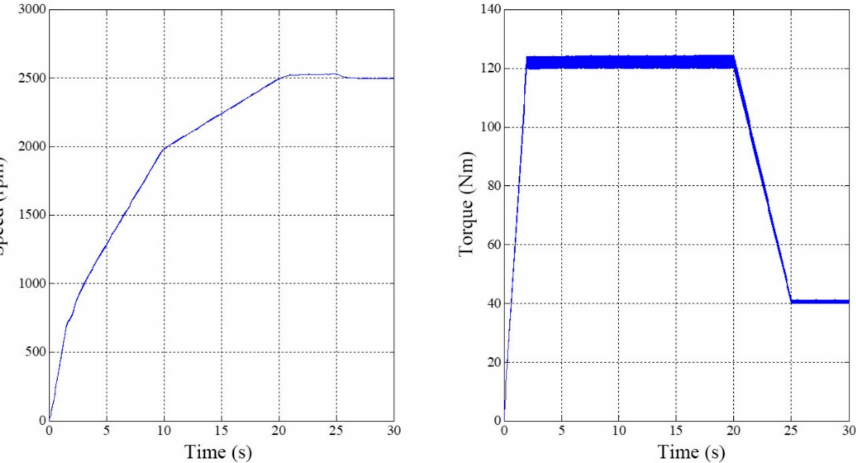
Figure 11. The speed and torque of the SRM in the starting process under the non-loaded